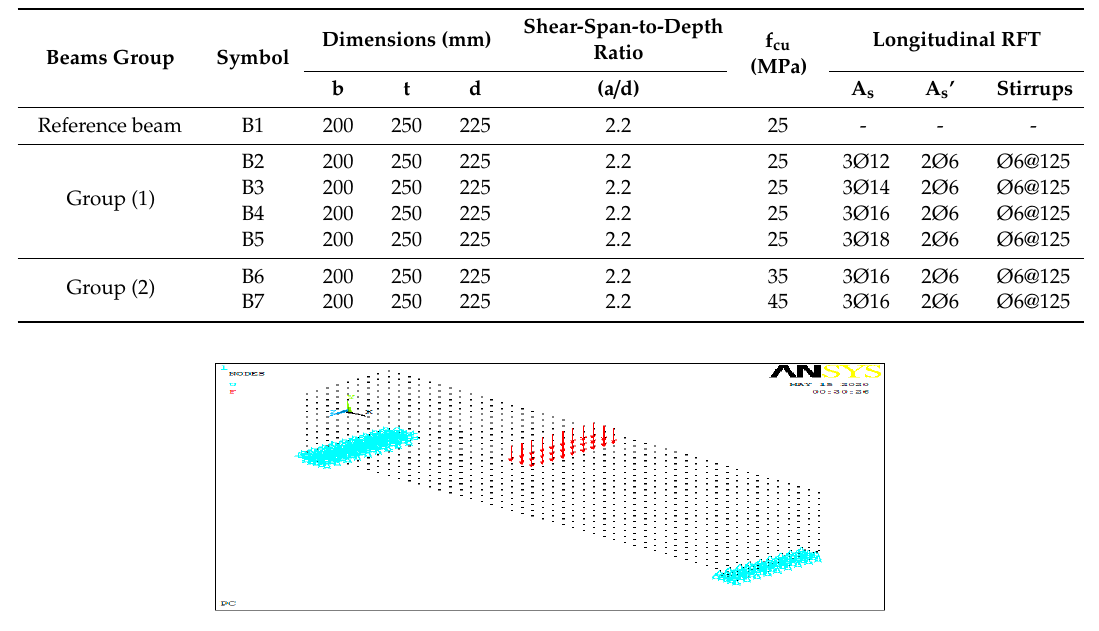
Figure 9. Loading and supports simulation.